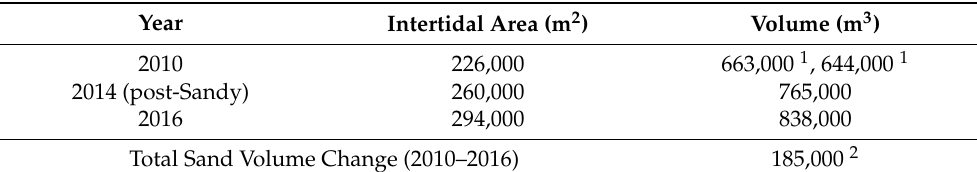
Figure 13. Changing morphology of Castle Neck River (outlined in red) behind Southern Spit, illustrating sand infilling between ( a ) 2008 (MassGIS) and ( b ) 2019 (Landsat Copernicus). Table 2. Inner flood-tidal delta geometry (based on NOAA Digital Coast data viewer using USGS and USGS CoNED project imagery).